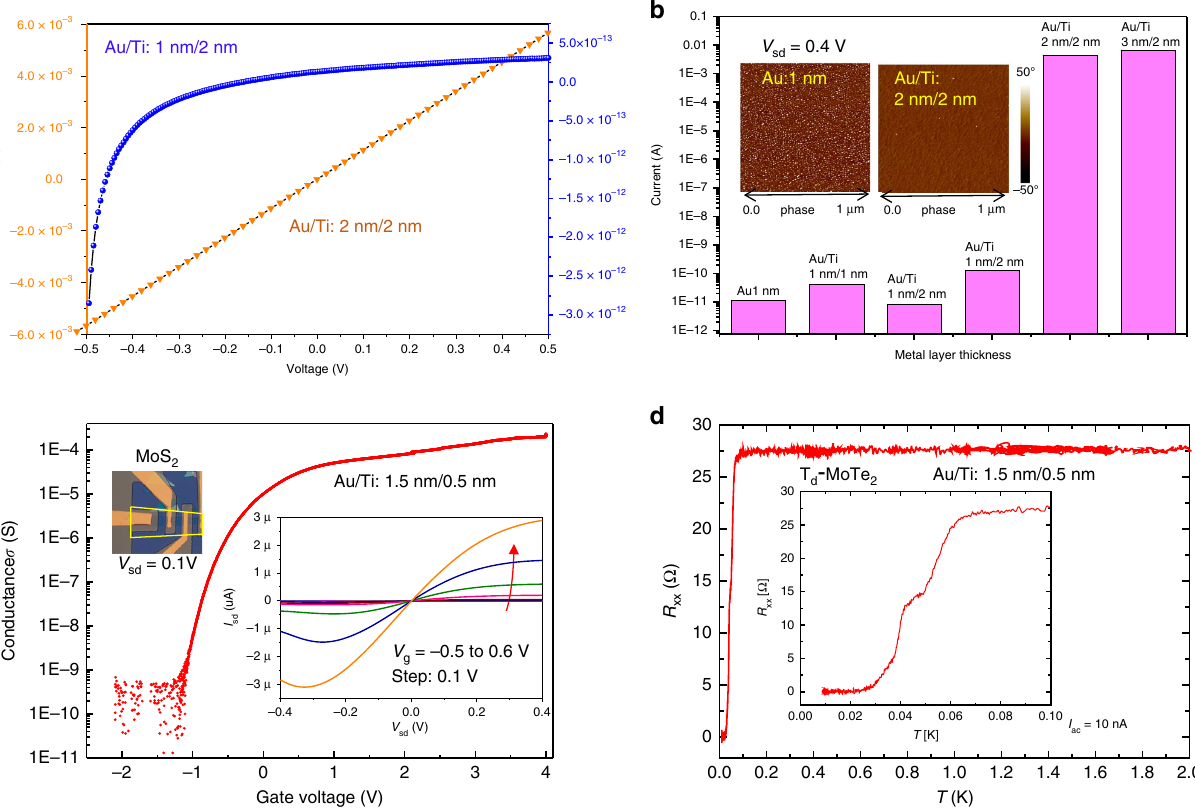
Fig. 4 Electrical measurements of metal adhesion layers and of 2D materials exfoliated onto nonconductive metal fi lms. a Electrical transfer curves of typical Au/Ti adhesion layers. b Two-terminal resistance of Au/Ti layers with different nominal thickness. The inset shows atomic force microscope (AFM) phase maps of two metal layers. c Gate voltage-conductance transfer characteristics of a top-gated MoS 2 FET on SiO 2 /Si with Au (1.5 nm)/Ti (0.5 nm) adhesion layer ( T = 220K, source − drain bias V sd = 0.1 V). Left inset: Optical image of the FET device with windows for the ionic-liquid top gate. Right inset: low-bias source-drain current-voltage characteristics for gate voltage − 0.5 to 0.6 V. d Temperature-dependent resistance of a T d -MoTe 2 fl ake exfoliated onto SiO 2 /Si with a 2 nm metal adhesion